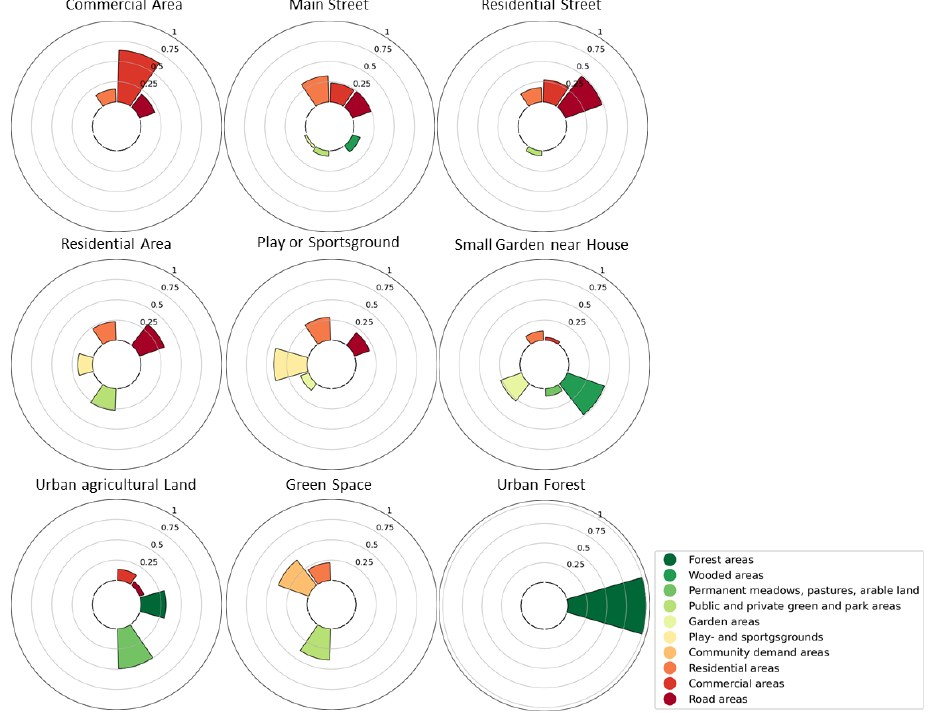
Figure A1. Percentage of land use area (as defined by Ruhr Regional Association [41]) in a 50m radius buffer around each recording station. Depicted are the ten largest land use types, which in total occupy more than 94% of the 50m buffer area.